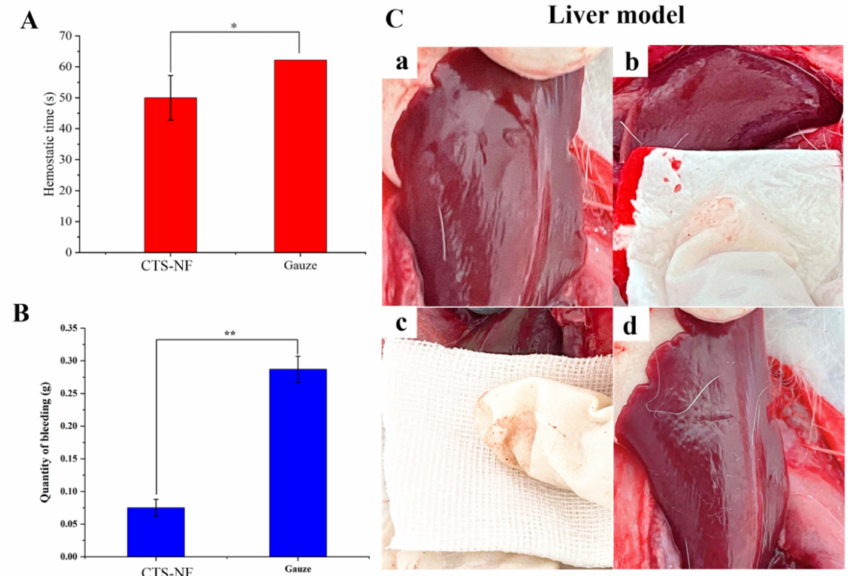
Figure 11. ( A ) The hemostasis time of the liver and ( B ) the amount of bleeding. ( C ) The liver model: Liver model bleeding ( a ), CTS-NF sponge hemostasis ( b ), medical gauze hemostasis ( c ), CTS-NF sponge wound ( d ). All data are expressed as the mean ± SD, n = 6). * p < 0.05, ** p < 0.01 indicates significant difference from the control